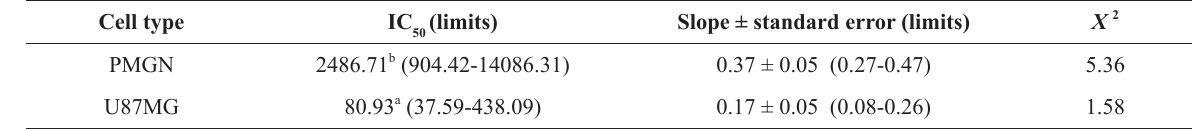
values for tested cells exposed to different treatments (mg/L). IC 50